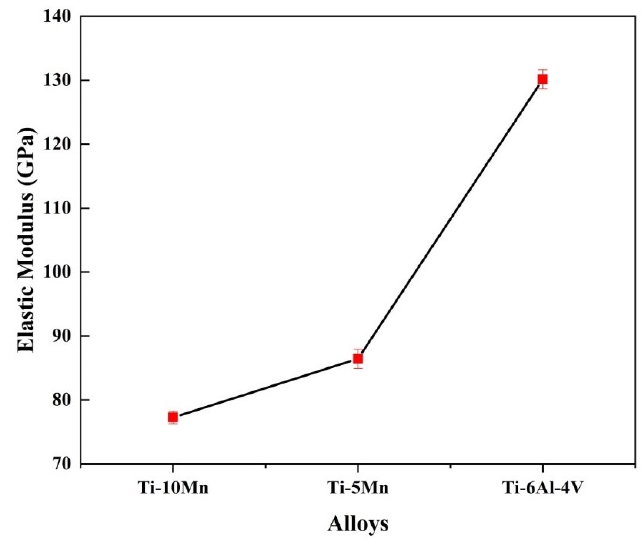
Figure 6. The reduced elastic modulus of the titanium-based alloys.